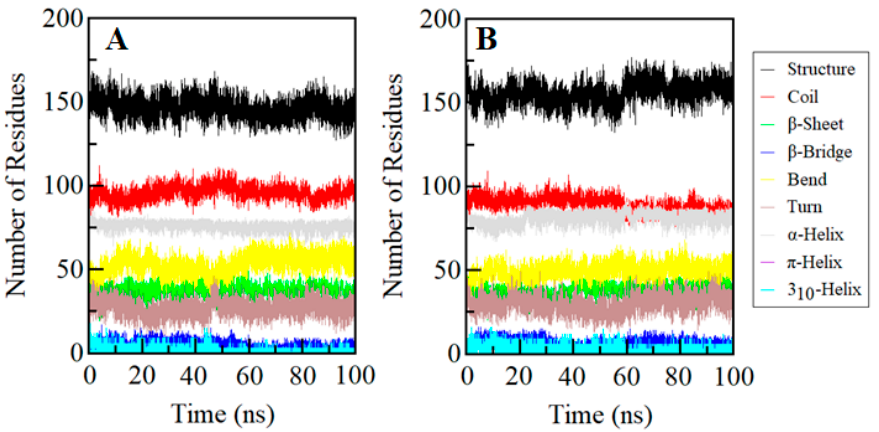
Figure 7. Secondary structure content in ( A ) Free SGK1 and ( B ) SGK1 upon ZINC00319000 binding. *Structure = α -helix + β -sheet + β -bridge + Turn. Table 8. The percentage of residues participated in the average structure formation of SGK1.